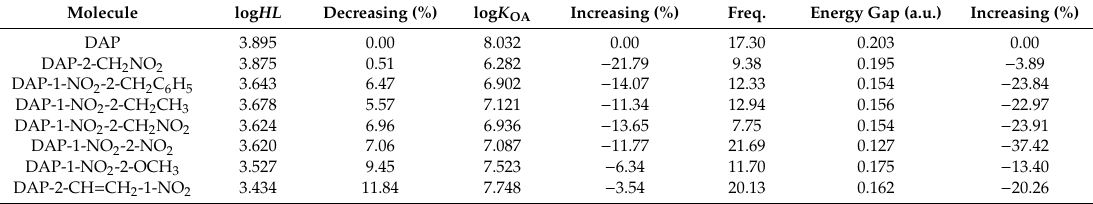
Table 8. Predicted log HL and log K OA values based on PAEs’ degradability, mobility 3D-QSAR models, Freq., and energy gap values based on Gaussian calculation. Molecule log HL Decreasing (%) log K